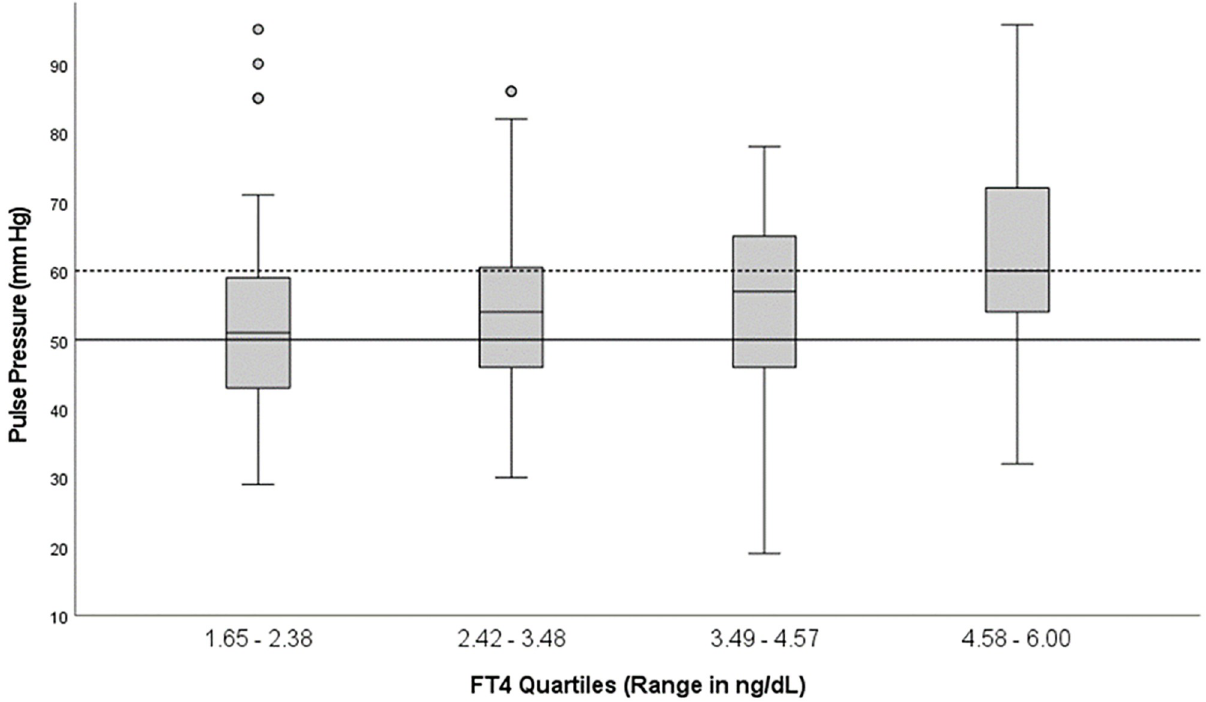
Fig 3. Median pulse pressure and IQR in four fT4 quartiles: Solid line represents widened pulse pressure > 50 mm Hg, whereas broken line denotes elevated pulse pressure > 60 mm Hg, a known risk factor for cardiomyopathy.